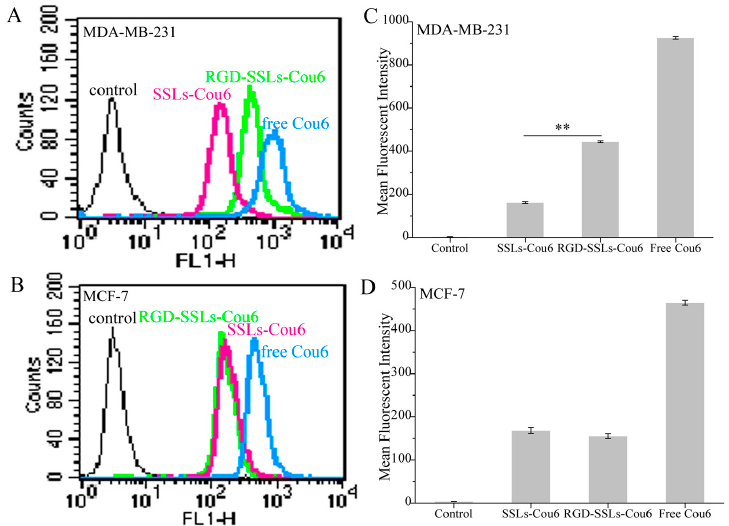
Figure 4. Flow cytometry profiles of: MDA-MB-231 ( A ); and MCF-7 cells ( B ) after treatment with SSLs-Cou6, RGD-SSLs-Cou6, and free Cou6 containing medium at concentration of 50 ng/mL for 1 h. Mean fluorescence intensity of: MDA-MB-231 ( C ); and MCF-7 cells ( D ) were assayed by flow cytometry experiments. ** p < 0.01.